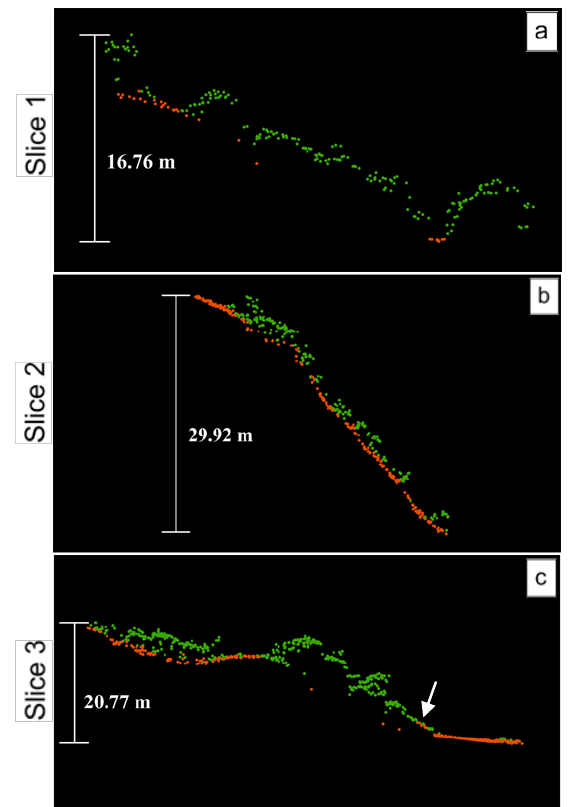
Figure 3. Integration results of three vertical slices of LiDAR point